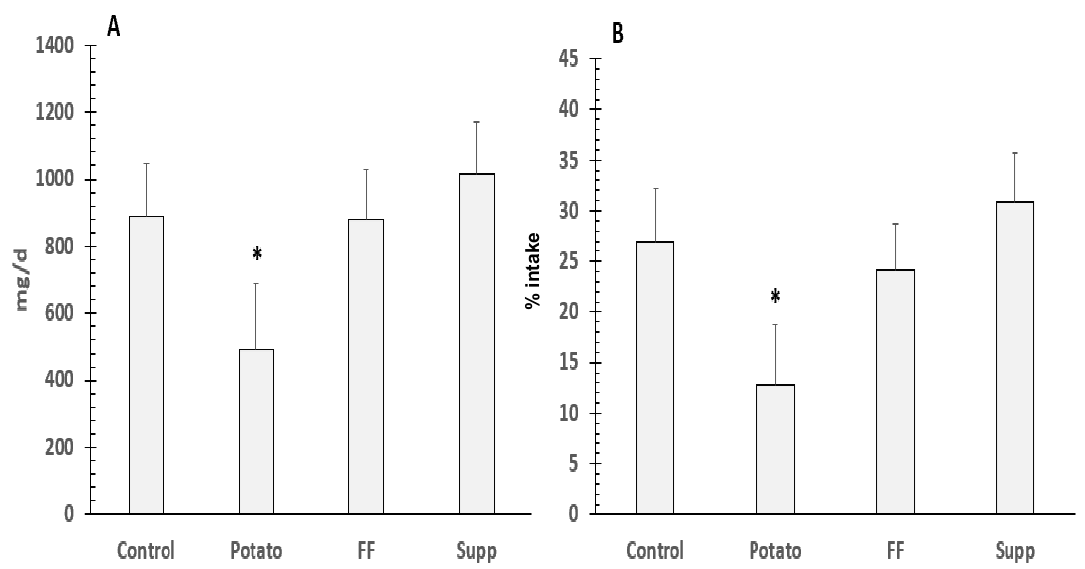
Figure 7. Differences in sodium retention as mg/d ( A ) and percent (%) of intake ( B ) in hypertensives on a controlled diet. * denotes significant difference ( p < 0.05) between potato and other groups. To convert to mmol/d, divide by